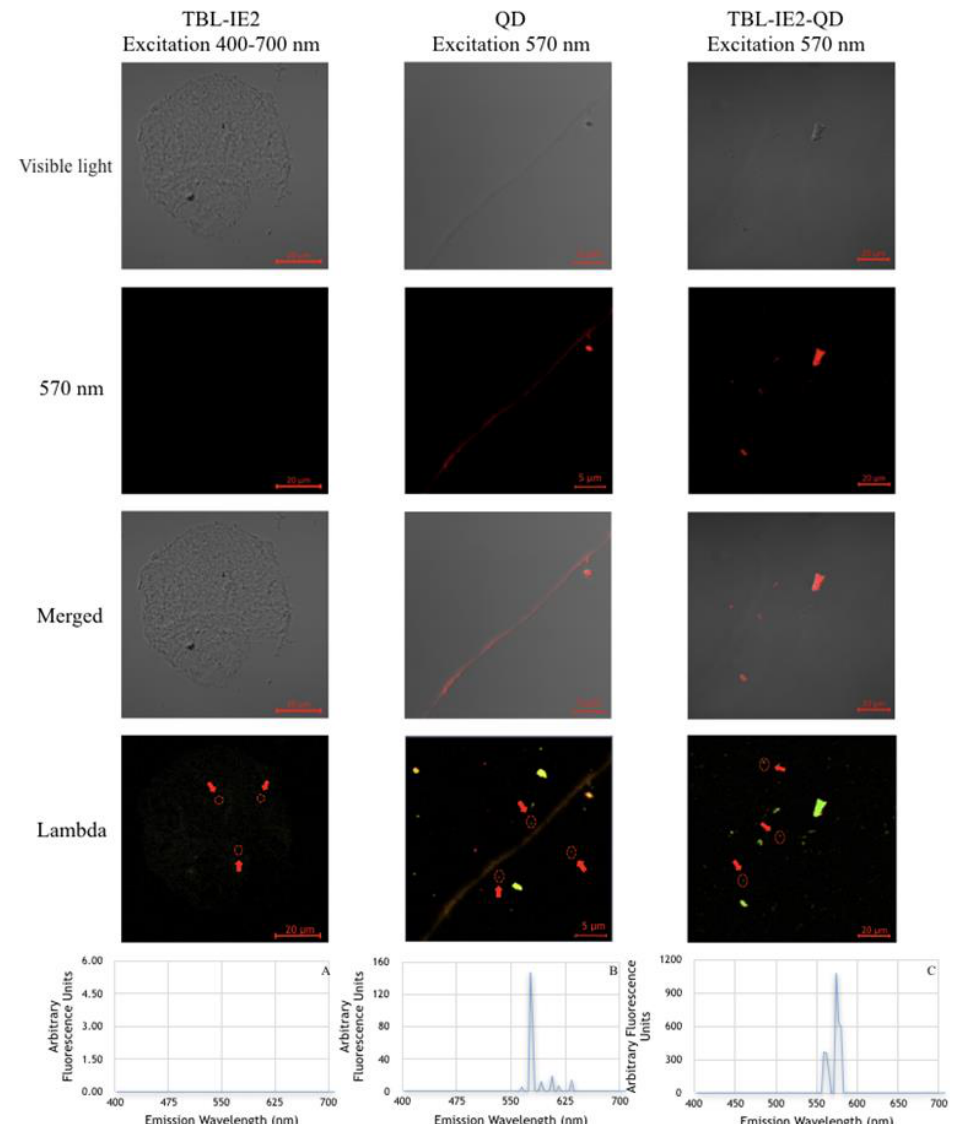
Figure 3. Fluorescence images for the TBL-IE2-QD complex. Analysis in visible light, excitation analysis at 570 nm, visible light and excitation at 570 nm merged, and lambda analysis from 400 to 700 nm (taking a reading every 2 nm). ( A ) TBL-IE2, lambda figure size 94.01 µm × 94.01 µm where no fluorescence was observed; ( B ) Quantum dots, lambda figure size 34.46 µm × 34.46 µm, with a single peak at 570 nm; ( C ) Analysis of the TBL-IE2-QD complex, lambda figure size 134.95 µm × 134.95 µm—a peak can be observed at 574 nm, and a second peak at 560 nm with less intensity.